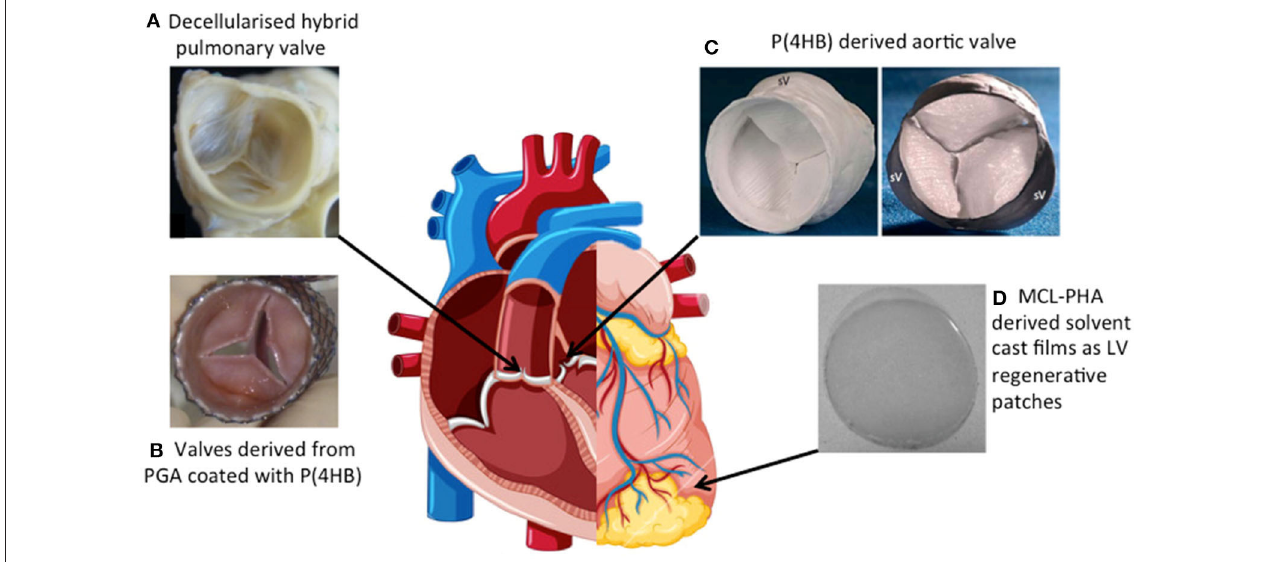
FIGURE 10 | Macroscopic images of (A) Decellularized porcine valves impregnated with P(4HB) and implanted into the pulmonary position of sheep for 12 weeks display viability and retain the overall structure of the valve ( 263). (B) A tissue engineered heart valve derived from PGA, coated with P(4HB) and subsequently seeded with either adult stem cells or vascular cells. It has been placed into a self-expanding stent and is to be delivered to the pulmonary position of sheep for 8 weeks (264). (C) Aortic grafts derived solely from P(4HB) following molding using a CT generated structure of a human aortic valve. SV highlights the Sinus of Valsalva ( 265). (D) Solvent cast film derived from MCL-PHAs that has been utilized for LV cardiac regeneration ( 266,